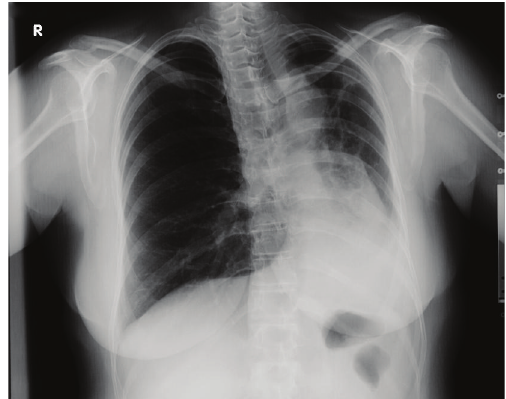
Figure 1: Chest radiograph showing loss of volume of her left lung with displacement of the mediastinum to the left.